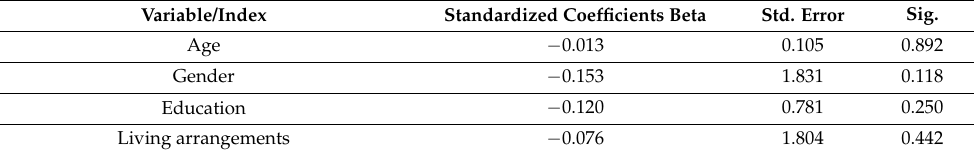
Table 2. Associations with dietary quality: results of multivariable